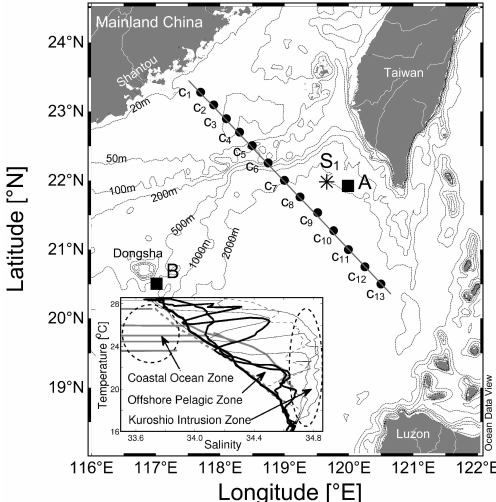
Figure 1. Sampling map in the northeastern South China Sea dur- ing May 2014. Dashed lines show the topography of the study area; solid dots are the stations for a transect study (C 1 − 13 ) during the period 14–16 May 2014; star is a time-series reference station (S 1 ) ; filled squares are two stations where shipboard dilution experiments were performed (A and B). Inset shows the temperature/salinity dia- gram for the transect with arrows indicating waters from the coastal ocean zone (thick gray lines), the offshore pelagic zone (thick black lines), and the Kuroshio intrusion zone (thin